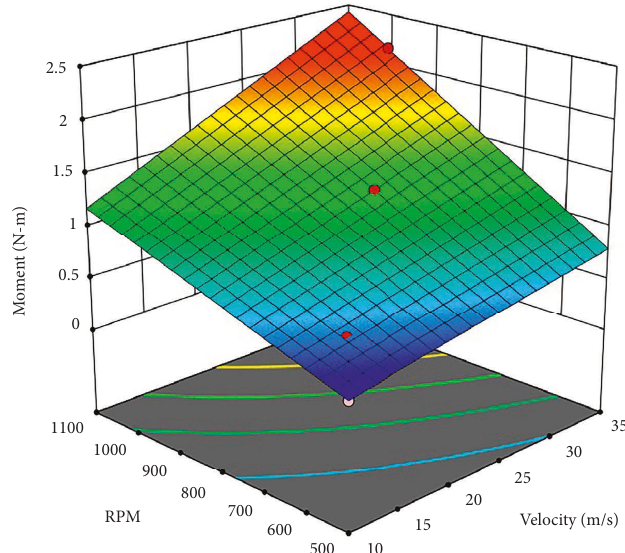
Figure 17: Moment measured for the HH02